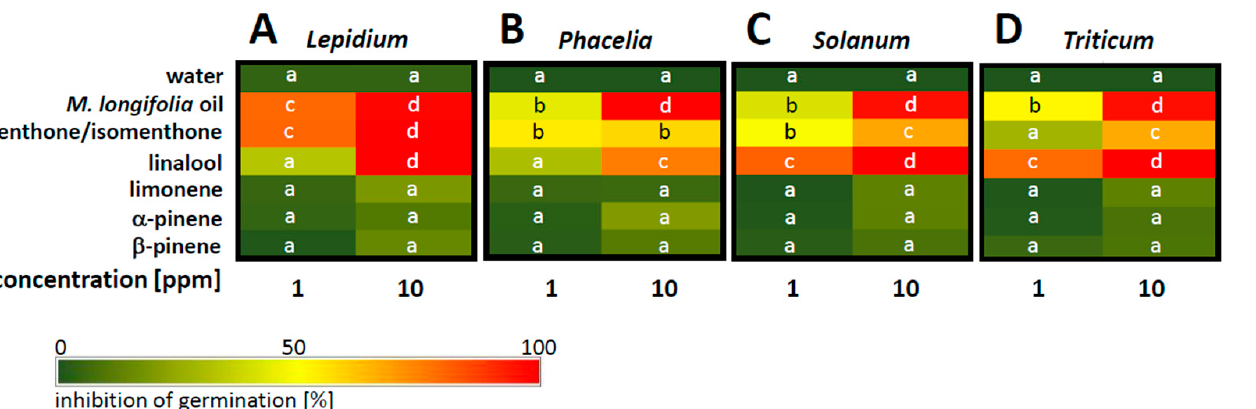
Figure 2. Response of cress seedlings to essential oils from di ff erent mints and of compounds found in these oils administered through the gas phase. ( A ) Inhibition of germination rate; mean values from fi ve independent replications collected in two di ff erent laboratories with 100–297 individuals scored for each experiment. White fi elds have not been determined. ( B , C ) Modulation of seedling growth for hypocotyl ( B ) or root ( C ). Data show mean and SE over those seedlings that had germinated. Le tt ers indicate groups that are di ff erent with respect to the Least Signi fi cant Di ff erence (LSD) test for a signi fi cance threshold of p < 0.05. ( D ) Experimental design of the study.